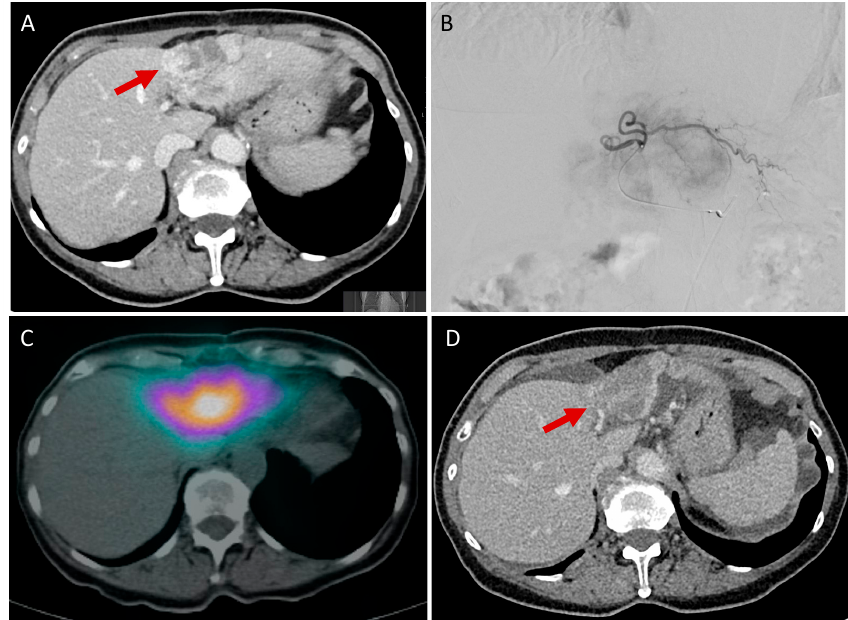
Figure 1. Example of intrahepatic CCA in liver segments II and III with vital tumor portions, as visible by the hypervascularized peripheral tumor parts ( A , red arrow). After selective internal radiotherapy using 0.44 GBq 90 Yttrium-loaded particles by catheter positioning in the left hepatic artery ( B ) and acquisition of a SPECT/CT ( C ), postinterventional follow-up 6 weeks after SIRT showed a marked decrease in vital tumor parts ( D , red arrow).